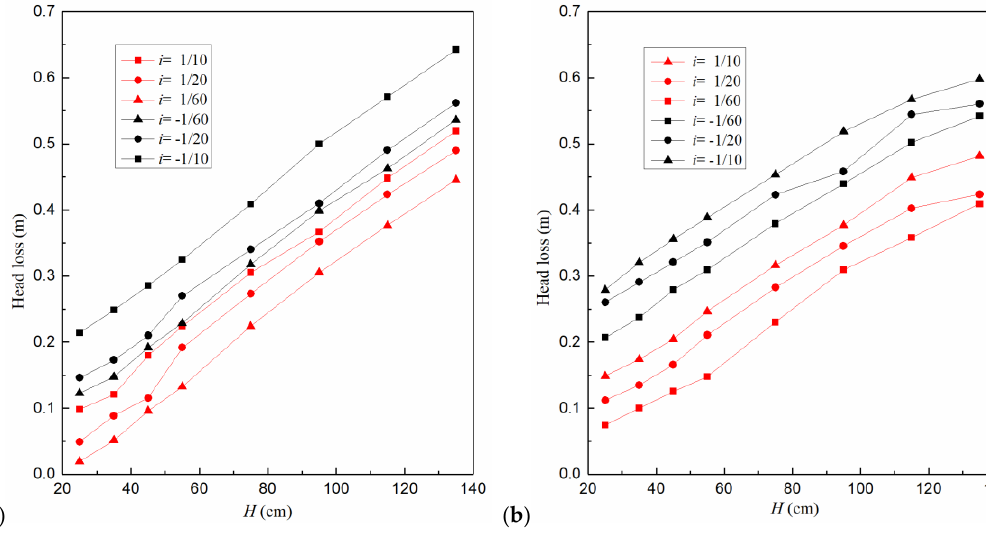
Figure 8. Variation of the head loss h w with water head under various slopes, h s = 6 m: ( a ) d = 3 cm, ( b ) d = 6 cm.